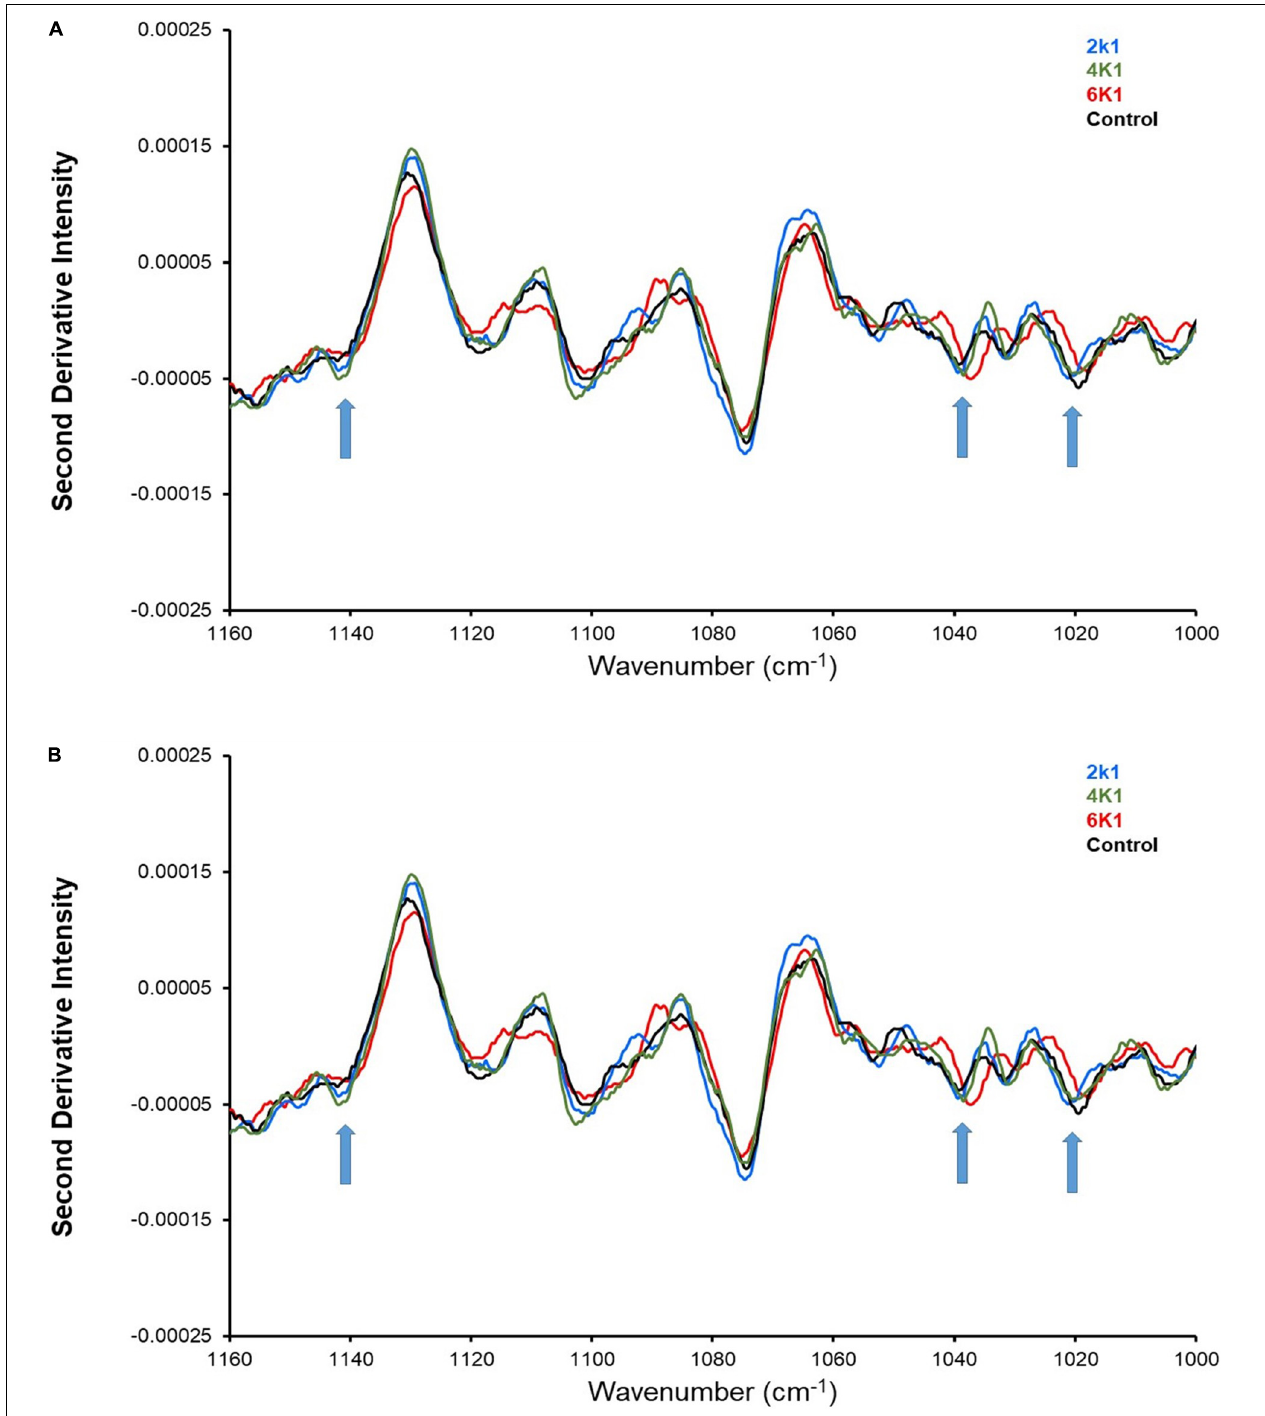
FIGURE 5 | ATR-FTIR analysis of control and HPP kabuli chickpeas with upward arrows indicating shift in spectra at 1,140, 1,040, and 1,020 cm - 1 (where 2K1 = 200 MPa, 1 min; 2K5 = 200 MPa, 5 min; 4K1 = 400 MPa, 1 min; 4K5 = 400 MPa, 5 min; 6k1 = 600 MPa, 1 min; and 6K5 = 600 MPa, 5 min).